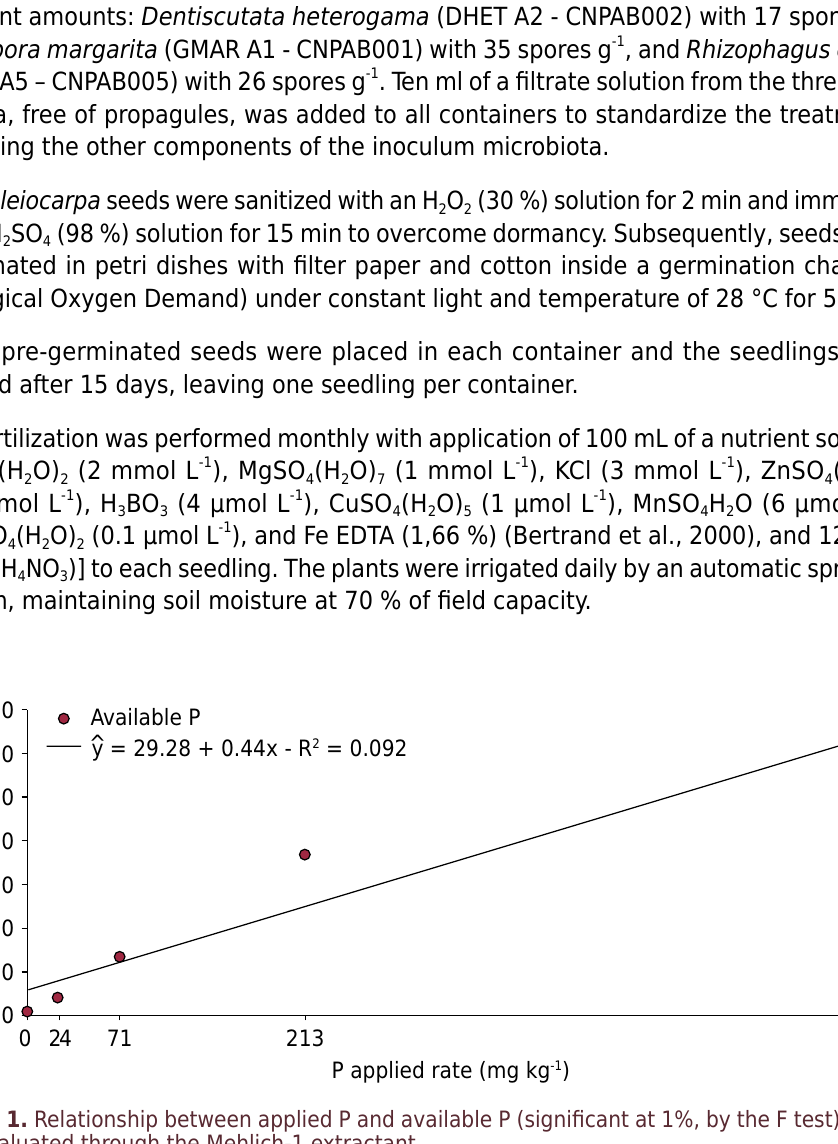
Figure 1. Relationship between applied P and available P (significant at 1%, by the F test) in the soil, evaluated through the Mehlich-1